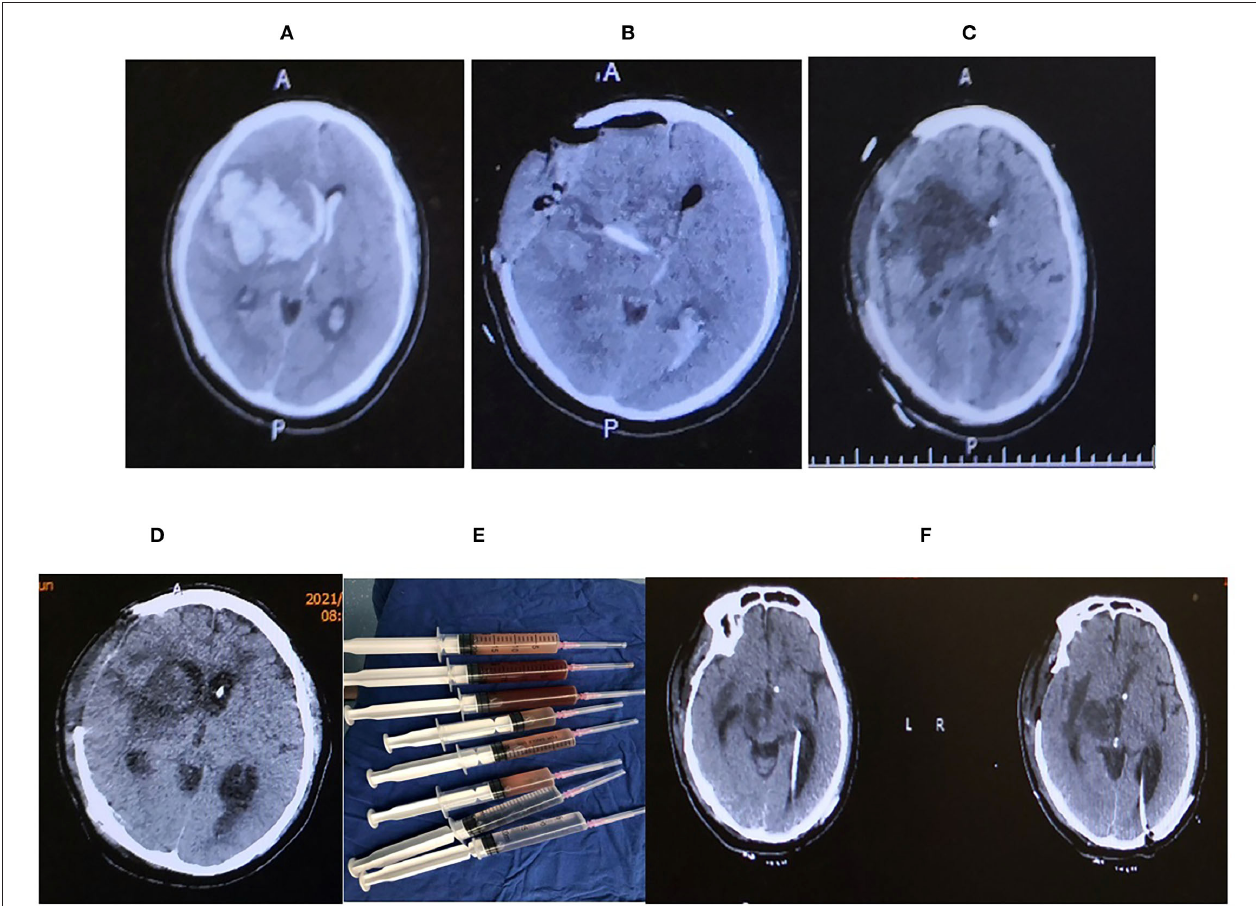
FIGURE 1 | (A) Axial CT showing massive right hemisphere intracranial hemorrhage (ICH) extending to the ventricle with a mid-line shift toward left. (B) The hematoma was evacuated following decompressive craniotomy with intracranial pressure (ICP) probe and external ventricular drainage (EVD) in situ . (C) Ommaya pump